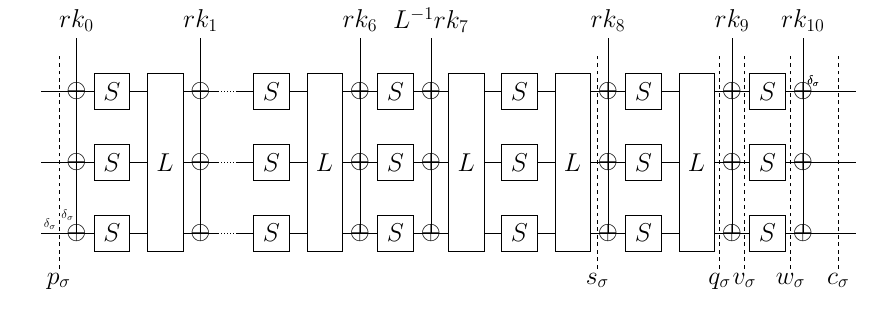
Figure 3: Overview of the